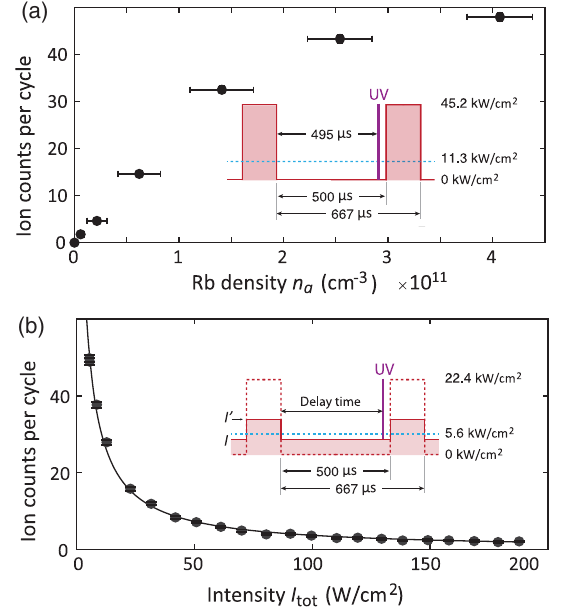
FIG. 3. Photoexcitation loss of KRb 2 (cid:1) collision complexes in a 1064 nm optical trap. (a) Steady-state KRb 2 þ ion counts measured for different initial atom number densities n and a normalized by the number of experimental cycles ( ∼ 100 for each data point). Vertical error bars represent shot noise, and horizontal error bars represent the 1 σ statistical uncertainty in the calibrated value of n . The inset shows the timing diagram used for the a measurement. The red curve is the total ODT intensity and the blue dashed line is its time average. (b) Steady-state KRb 2 þ ion counts measured at different total ODT intensities with ¼ 4 . 1 ð 3 Þ × 10 11 cm − 3 , and normalized by the number of n a experimental cycles ( ∼ 50 for each data point). Error bars represent shot noise, and the solid line is a fit to the data using Eq. (2). The inset shows the timing diagram used for the measurement. The red curve is the intensity of the V ODT, where the intensity during the “ high ” phase of the modulation period is I 0 , and that during the “ low ” phase is I . To control I , tot we vary the V ODT modulation depth while keeping the time- averaged intensity fixed at the continuously operated level, 5 . 6 kW = cm 2 (blue dashed line). The red dashed line is the intensity profile at full modulation depth. The H ODT, not shown here, follows the V ODT timing, but is always modulated at full depth with a time-averaged intensity equal to its continuously operated level, 5 . 7 kW = cm 2 . All data shown in (a) and (b) are taken with B ¼ 30 G and E ¼ 17 V =